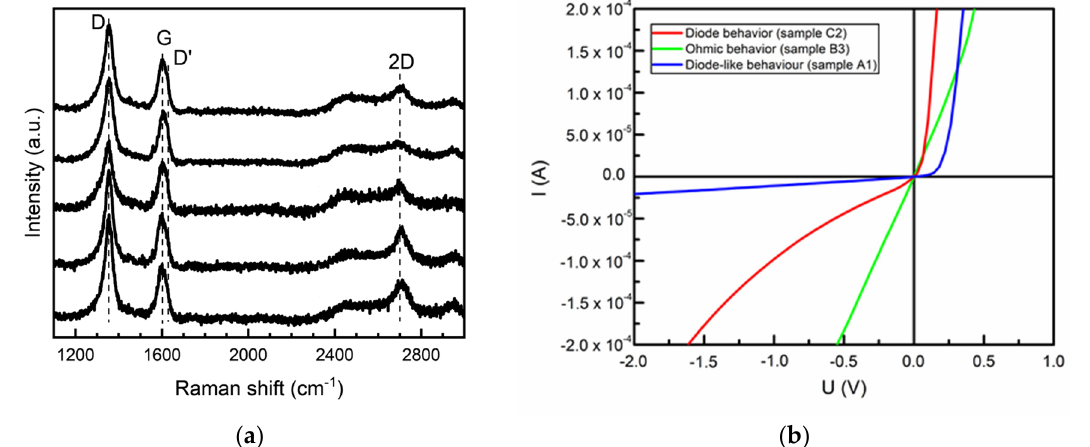
Figure 2. Typical Raman scattering spectra ( a ) and typical I−V characteristics ( b ) of directly synthe- sized graphene/Si(100) devices. The I−V characteristics of the device produced from the C2 sample exhibited diode behavior (red), ohmic contact was seen for the device produced from a sample B3 (green), and the A1 sample had diode-like I-V features (blue).